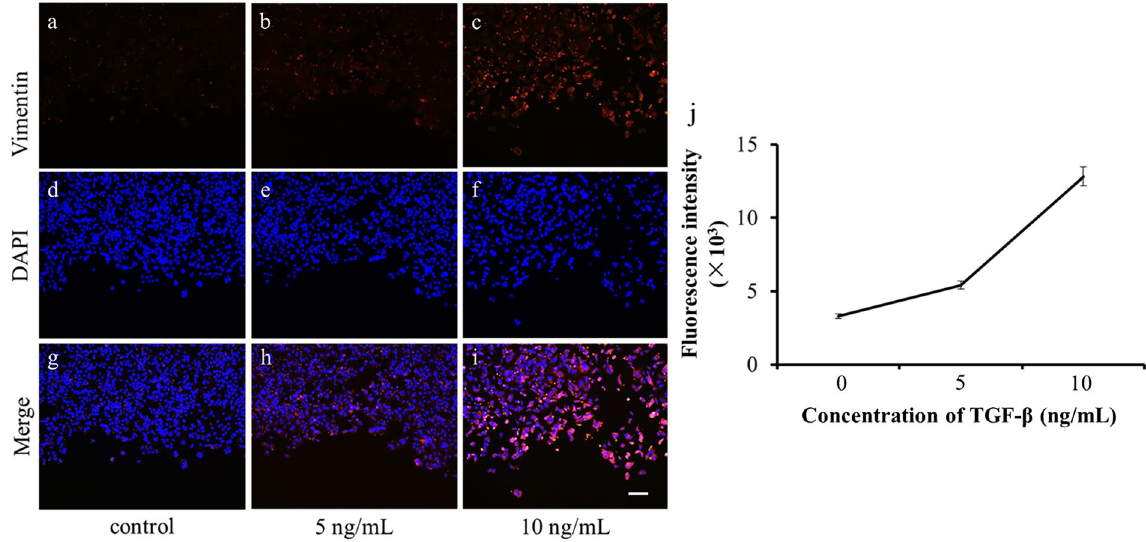
Figure 7. The effect of TGF- β on vimentin expression. ( a – c ) Cells were fixed and stained with anti-vimentin antibody (red) after treatment with different concentrations of TGF- β (0, 5 and 10 ng/mL). ( d – f ) Cells were fixed and stained for nuclei with DAPI (blue) after treatment with different concentrations of TGF- β (0, 5 and 10 ng/mL). ( g – i ) Merged images for a-f. ( a , d , and g ) Control. ( b , e , and h ) 5 ng/mL TGF- β . ( c , f , and i ) 10 ng/mL TGF- β . ( j ) Fluorescent intensity of vimentin. The scale bar in the picture represents 100 μ